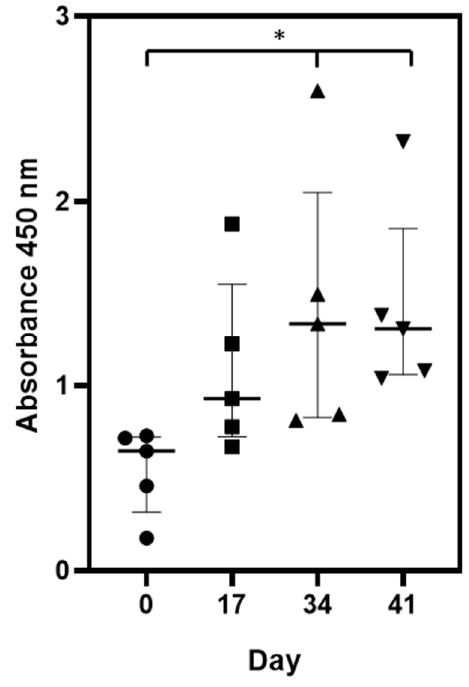
Figure 5. Dynamics of anti-H5N1 IgY level in sera of immunized chickens. Kinetics of antibody titer in chickens ( n = 5) following prime and boost vaccinations with triple H5N1/NA-HA-M1 VLPs were measured via ELISA test. The median (thick line) is shown with the interquartile 25% and 75% range (narrow lines). The day of the serum collection is shown on the x-axis. The A450 values are shown on the y-axis. Statistical analysis was performed using the nonparametric Kruskal–Wallis test ( p = 0.05) and Benjamini, Krieger and Yekutieli multiple comparison test ( p = 0.05). Statistical differences were detected between days 0–41 and 0–34 ( p = 0.014) and shown on the graph as a star symbol. An analysis of antibody titers in blood collected at 0, 17, 34 and 41 days of the experiment revealed a steady increase in the humoral response after broiler immunization with triple H5N1/NA-HA-M1 VLPs. Robust production of the antibodies was detected after the first dose of the vaccine. The second dose of triple H5N1/NA-HA-M1 VLPs did not significantly increase the number of antibodies produced. Additionally, to evaluate the efficacy of the vaccination, an HI assay was performed. The HI titer of pooled chicken sera reached the level of 128 HI (Figure 6). It is estimated that samples are positive when the HI titer reaches ≥ 16. As a positive control, inactivated H5N1 A/Ck/Scot/59 and H5N2 A/Ost/Den/72420/96 viruses were used. The PBS vaccinated hens did not show any HI activity.